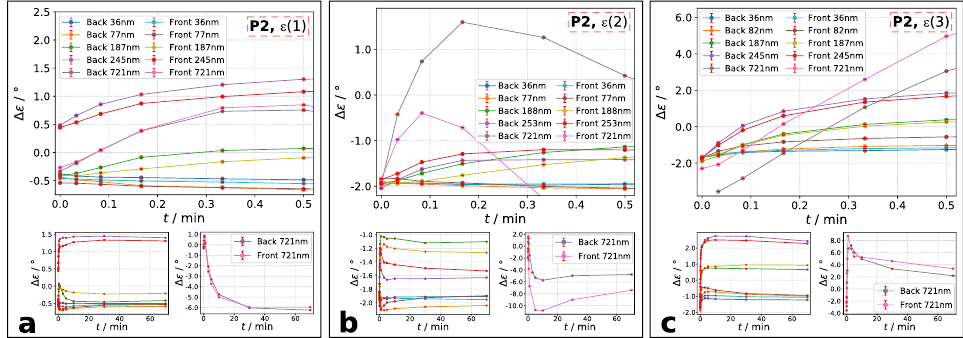
Figure 9. Polymer P2 : change of ellipticities compared to incident ellipticity ∆ (cid:101) = (cid:101) a,t − (cid:101) a,i during the first 30 s of irradiation. Ellipticity combination is: ( a ): (cid:101) ( 1 ) , ( b ): (cid:101) ( 2 ) , and ( c ): (cid:101) ( 3 ) . Denotation: main plot: ∆ (cid:101) at exposure time up to 30 s; left small plot: ∆ (cid:101) for films with up to d = 245nm. right small plot: ∆ (cid:101) for d = 721nm. The combination of (cid:101) ( n ) is labelled in each main plot.